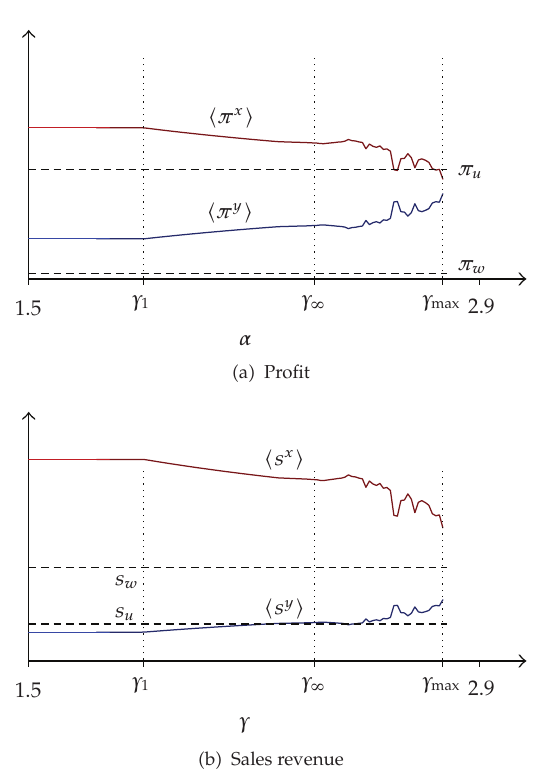
Figure 4: Long-run averages with respect to γ (cid:2) m (cid:6) 3 ,c (cid:6) 1 / 2 (cid:3)